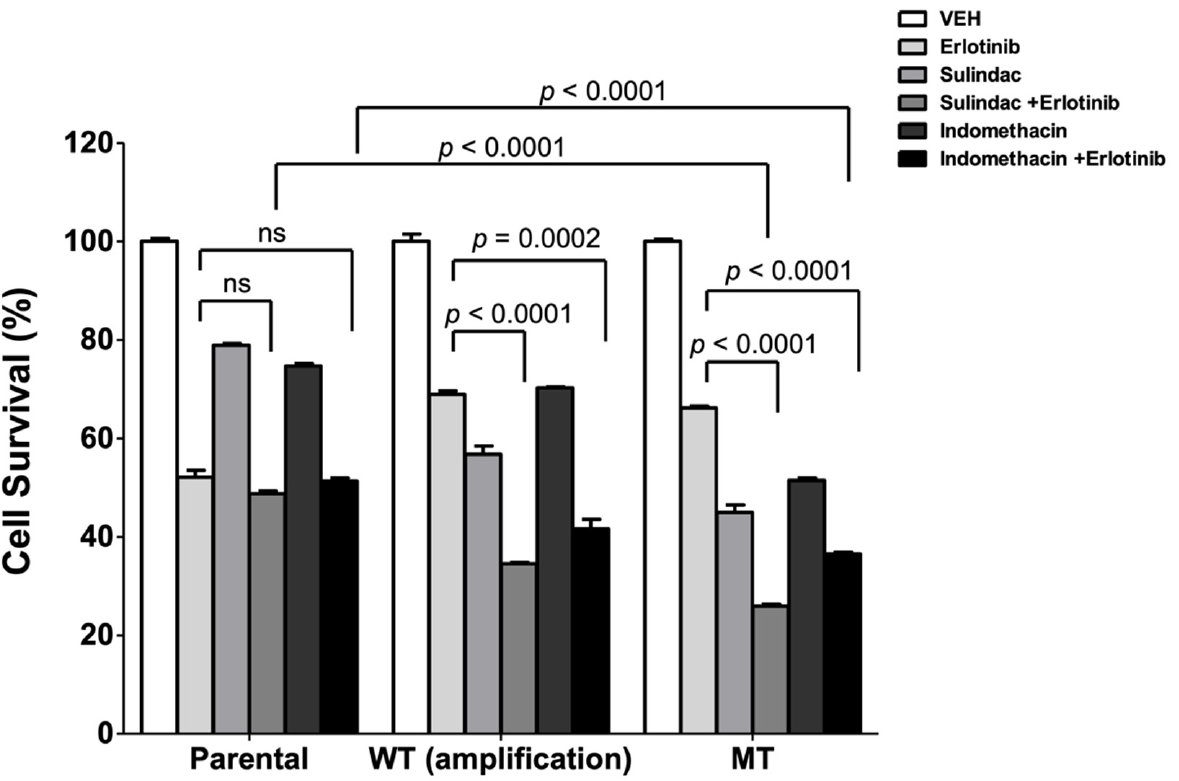
Figure 4. Combination of NSAID with erlotinib markedly inhibits cell survival in isogenic HNSCC cells overexpressing mutant PIK3CA. PCI-52 parental cells and isogenic cells overexpressing WT or MT (H1047R) PIK3CA were treated with vehicle, erlotinib (2 µ M), sulindac (100 µ M), indomethacin (100 µ M), or combination of sulindac and erlotinib or indomethacin and erlotinib for 48 h followed by MTT assay. p values were calculated using a two-tailed T -test. Bars represent mean + SEM. ns: not significant.